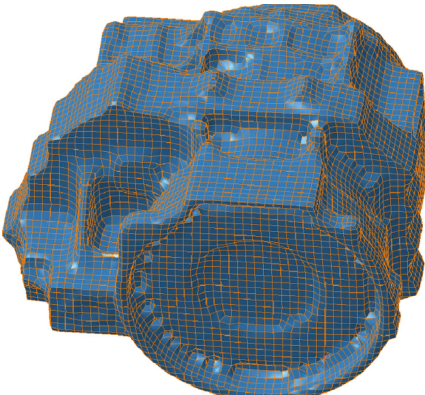
Figure 8: BEM model of the